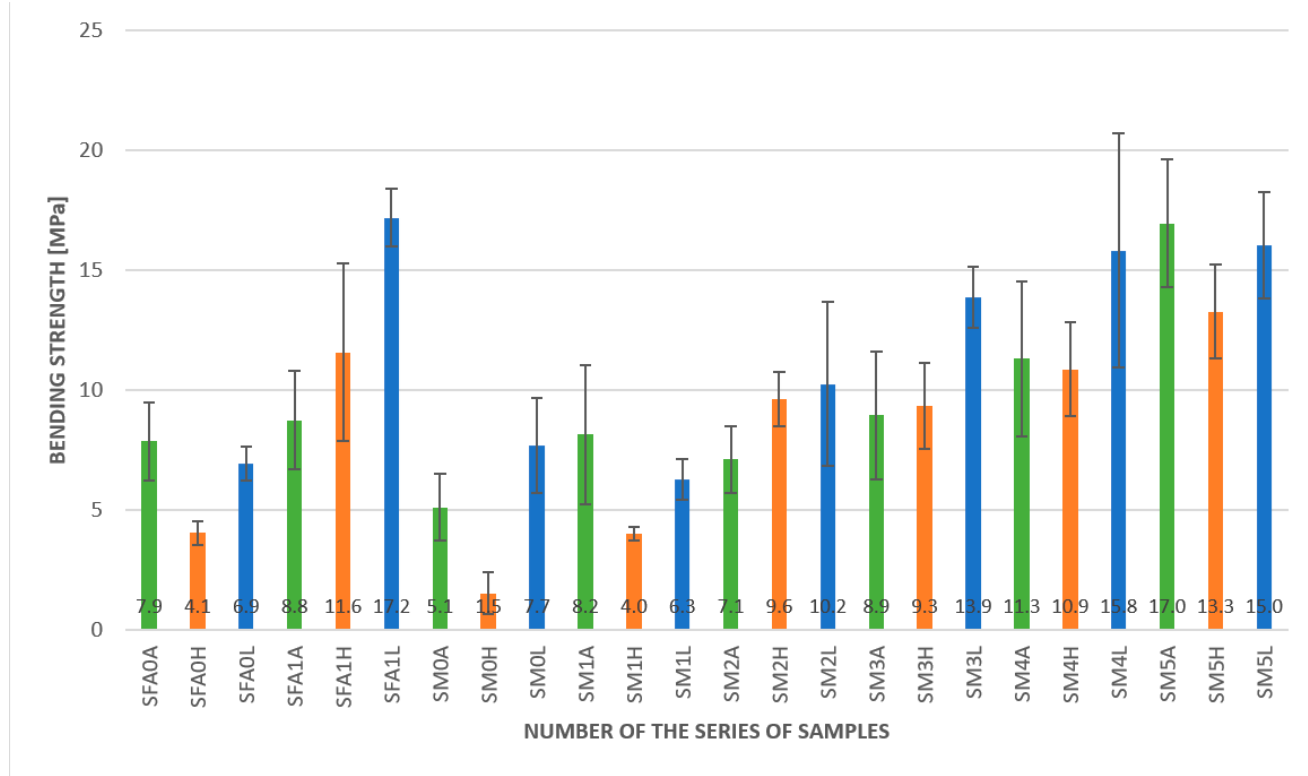
Figure 11. Results of the bending strength test for geopolymer composites—comparison at different temperatures.